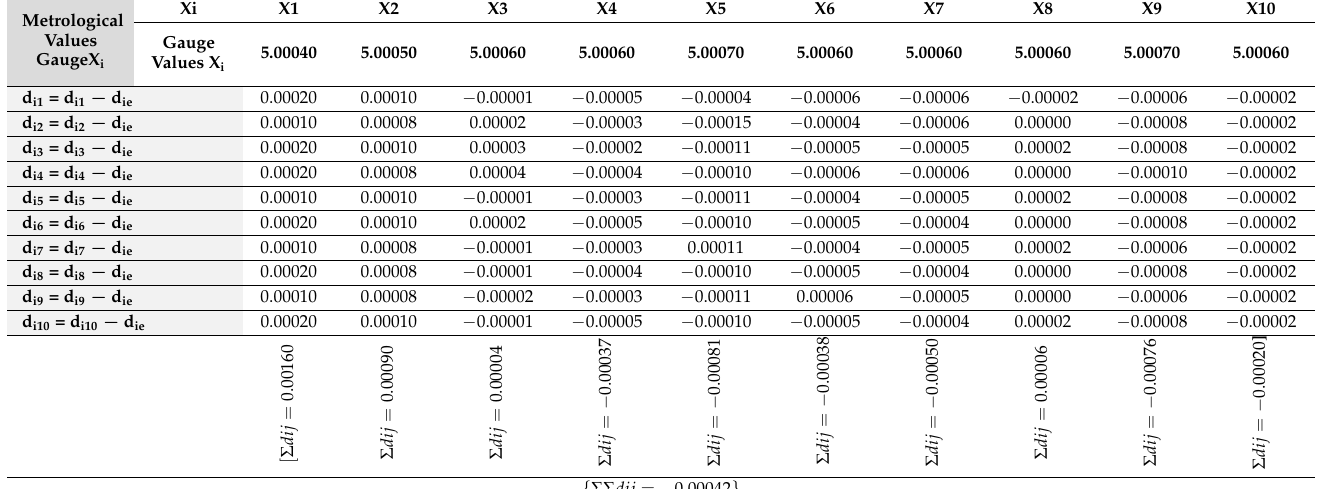
Table 3. Protocol of metrological measurements for determination of metrological values (E5 mm